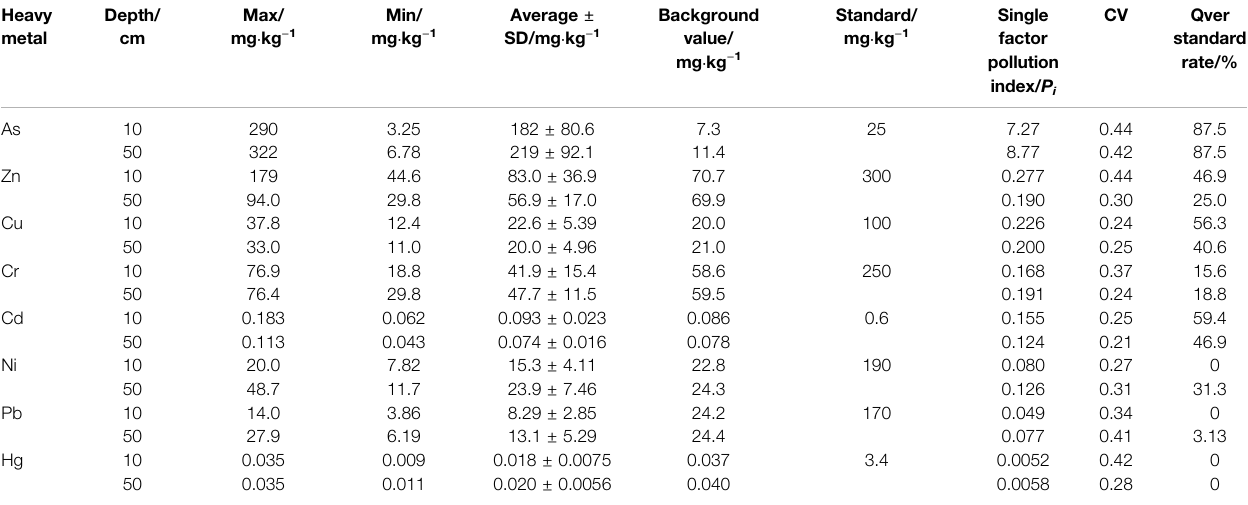
TABLE 1 | The statistical analysis of heavy metals in the soils. Heavy Depth/ metal cm